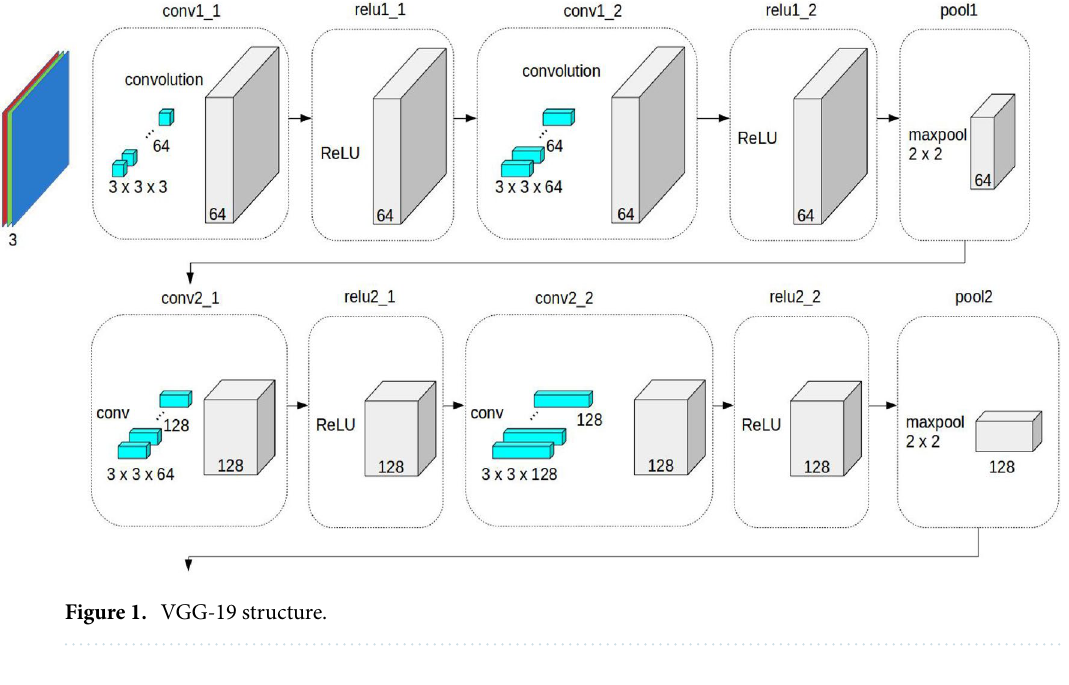
Figure 1. VGG-19